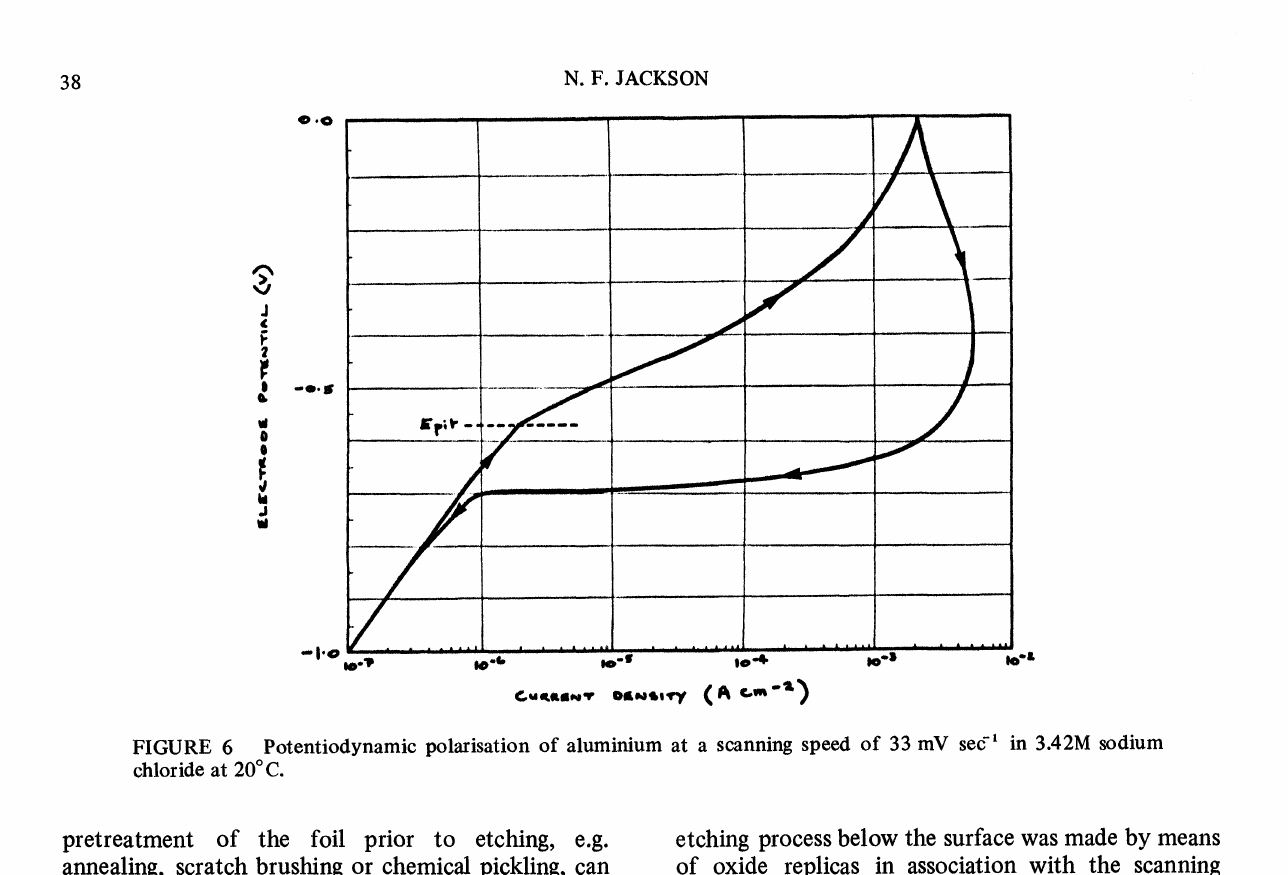
FIGURE 6 Potentiodynamic polarisation of aluminium at a scanning speed of 33 mV sec chloride at 20 C.